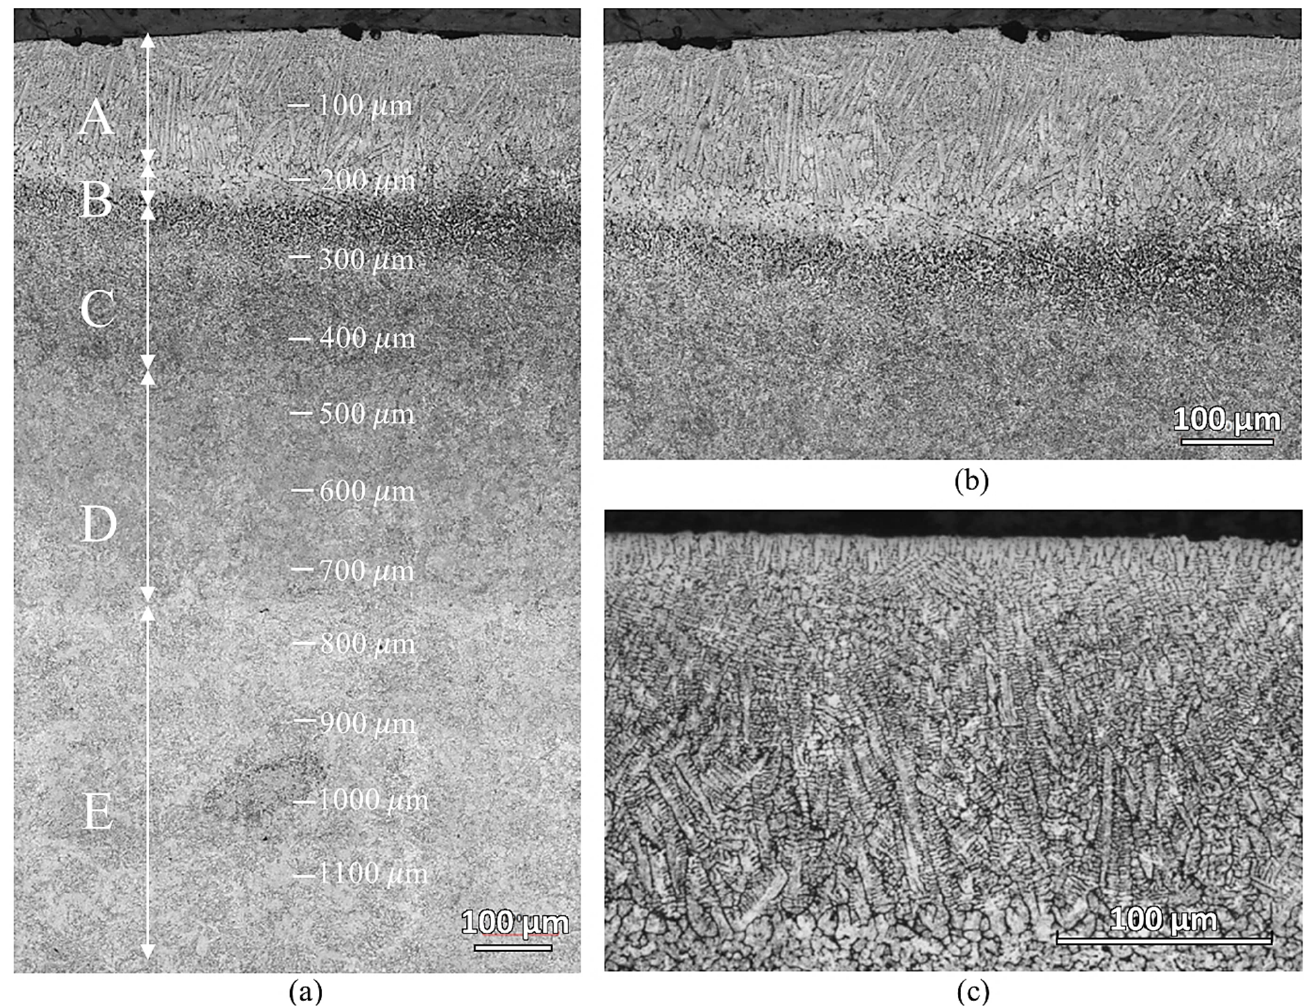
Figure 5. Optical micrographs of the laser-hardened sample: ( a ) low magnification micrograph showing five distinct microstructure zones; ( b , c ) higher magnification micrographs showing the microstructure of laser-hardened region.